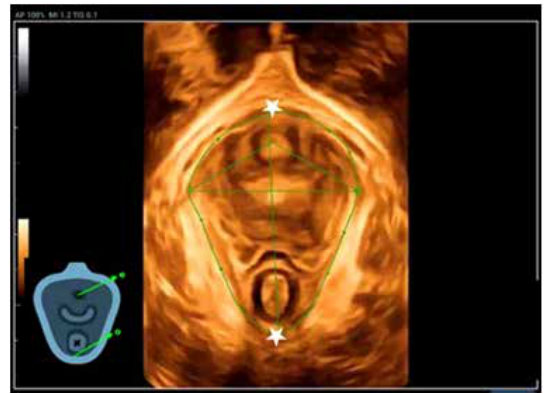
Figure 7 A volumetric ultrasound of the pelvic floor is depicted with the automated annotation and measurement of key standardized perimeters using intelligent post-processing software via the Mindray Resona 7 system. Image provided by